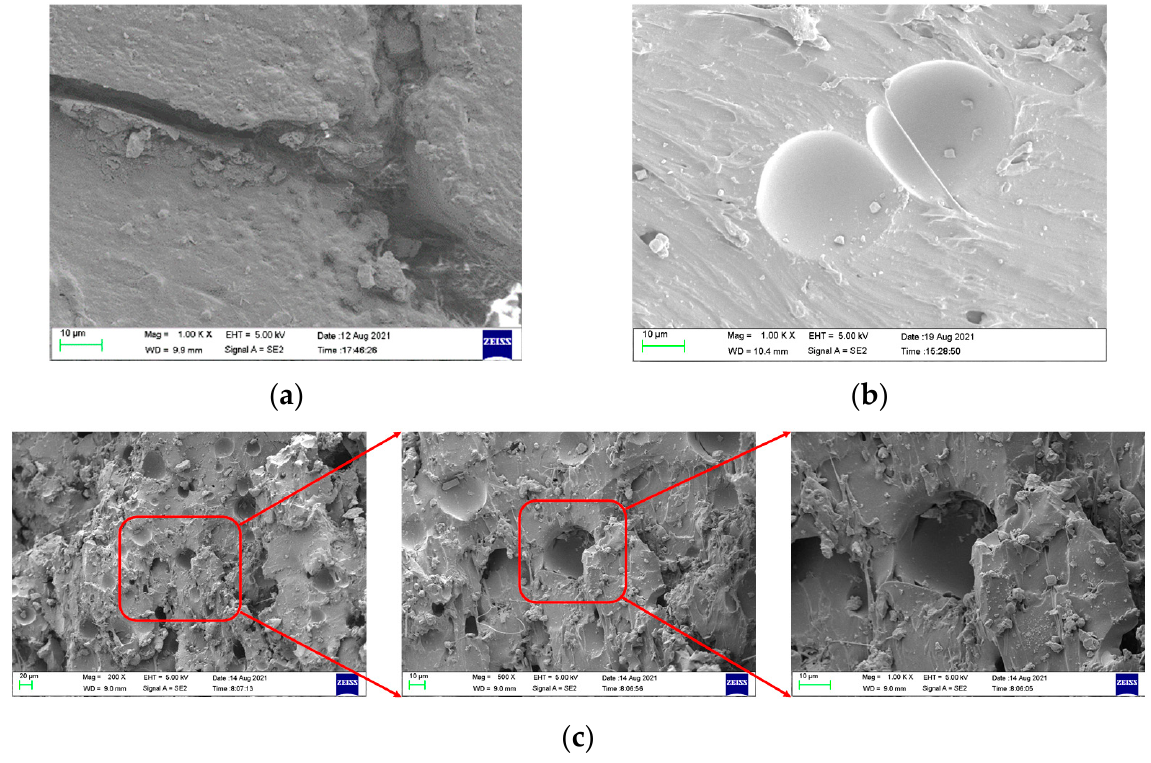
Figure 7. SEM images of polyurea on the target of configuration F and in the initial state. ( a ) Surface area. ( b ) The initial state of the polyurea. ( c ) Fracture area debris.